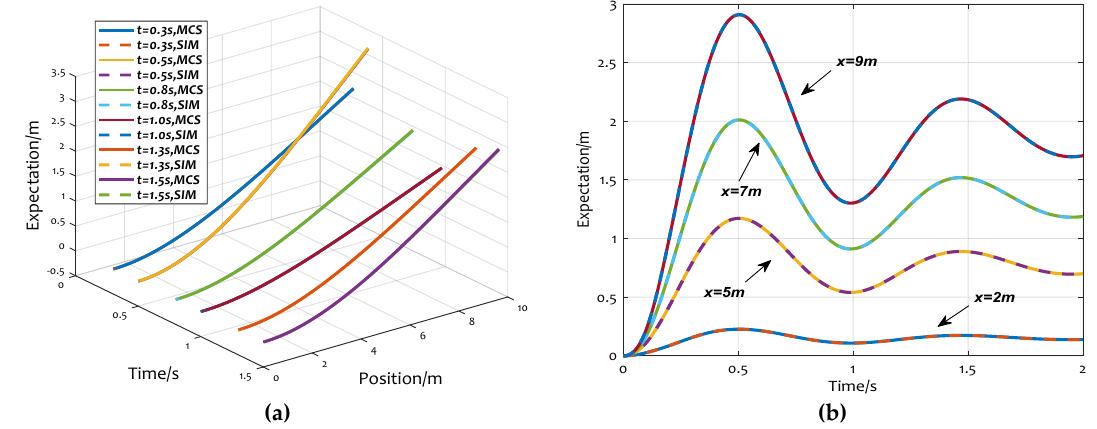
Figure 6. Displacement expectations between MCS and SFEM: ( a ) displacement expectations at different time; ( b ) node displacements at different positions.